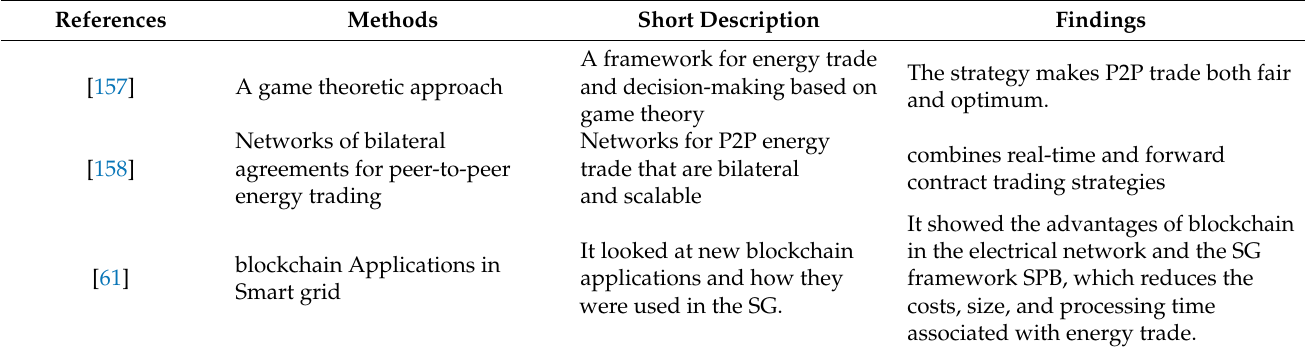
Table 8. Blockchain-Based Detection and